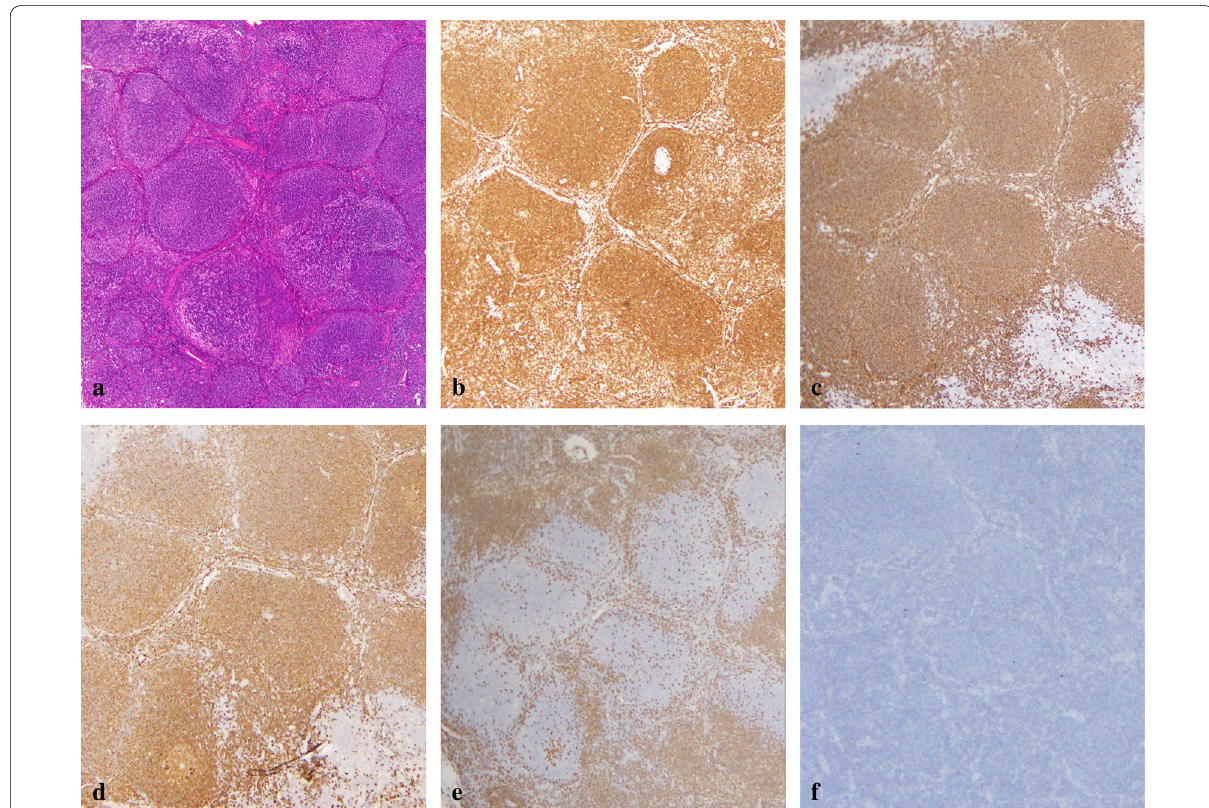
Fig. 4 a Hematoxylin–eosin staining of the lymph node showing nodular proliferation of atypical lymphoid cells composed predominantly of centrocytes with admixed scattered centroblasts. b – f Immunohistochemical staining revealing that the lymph node is positive for bcl‑2 ( b ), CD20 ( c ), and CD79a ( d ) and negative for CD3 ( e ) and CD30 ( f